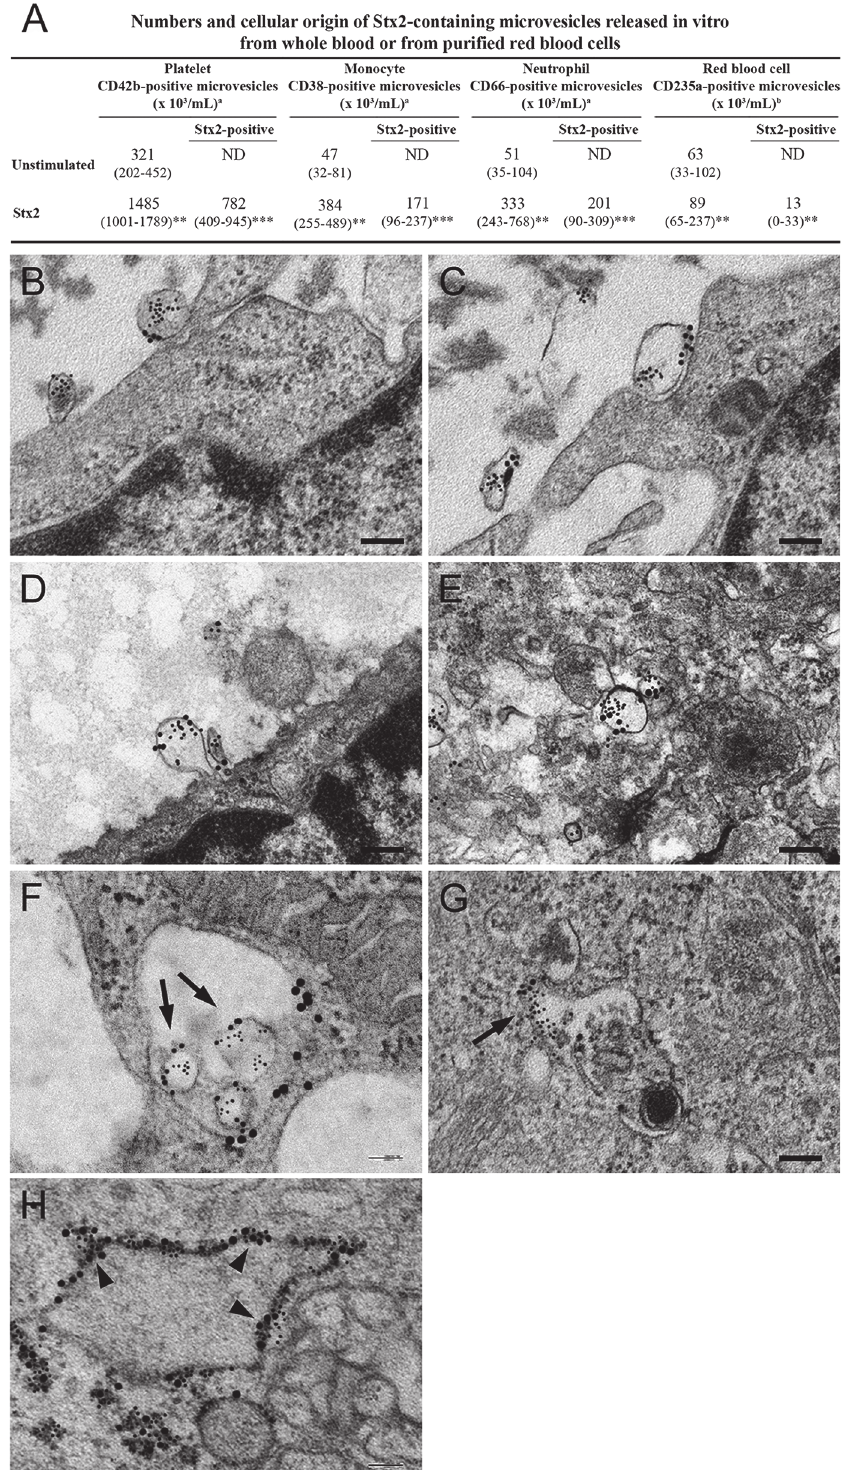
Fig 4. Blood cell-derived microvesicles transfer Stx2 to glomerular endothelial cells in vitro. ( A ) Data are expressed as median and (range) of microvesicles positive for each membrane specific marker/mL of plasma. a , Microvesicles released from whole blood (n = 6). b , Microvesicles released from purified RBCs (n = 10). *** Denotes P value < 0.001, ** P < 0.01 and * P < 0.05 when comparing microvesicle generation in